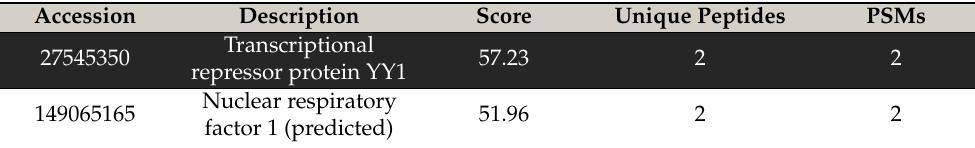
Table 2. Mass spectrometry analyses data of protein (APP2) purified through Biotin-OL2 DNA beads. Transcriptional repressor protein YY1 highlighted with white text on black background.